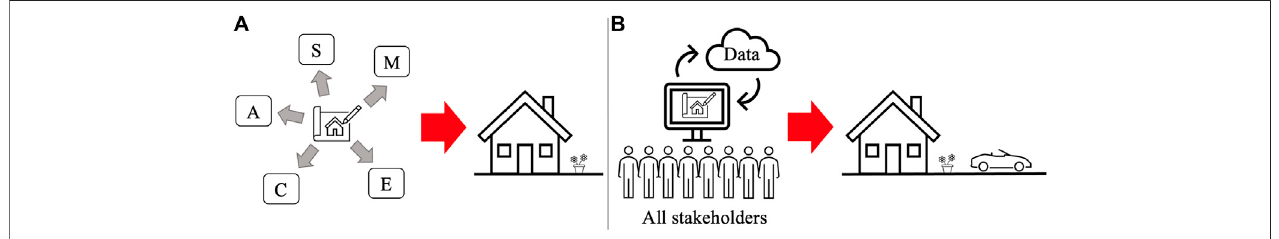
FIGURE 1 | Traditional (A) and BIM process (B) (adopted from Azhar et al. (2012)).